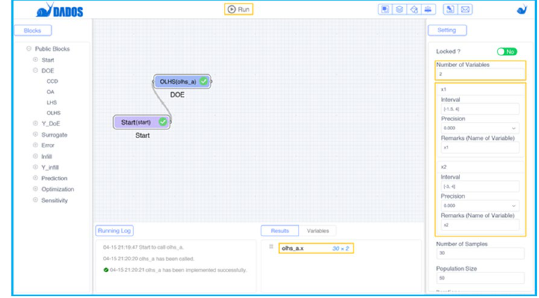
Figure 13 Configuration of the OLHS block for the numerical